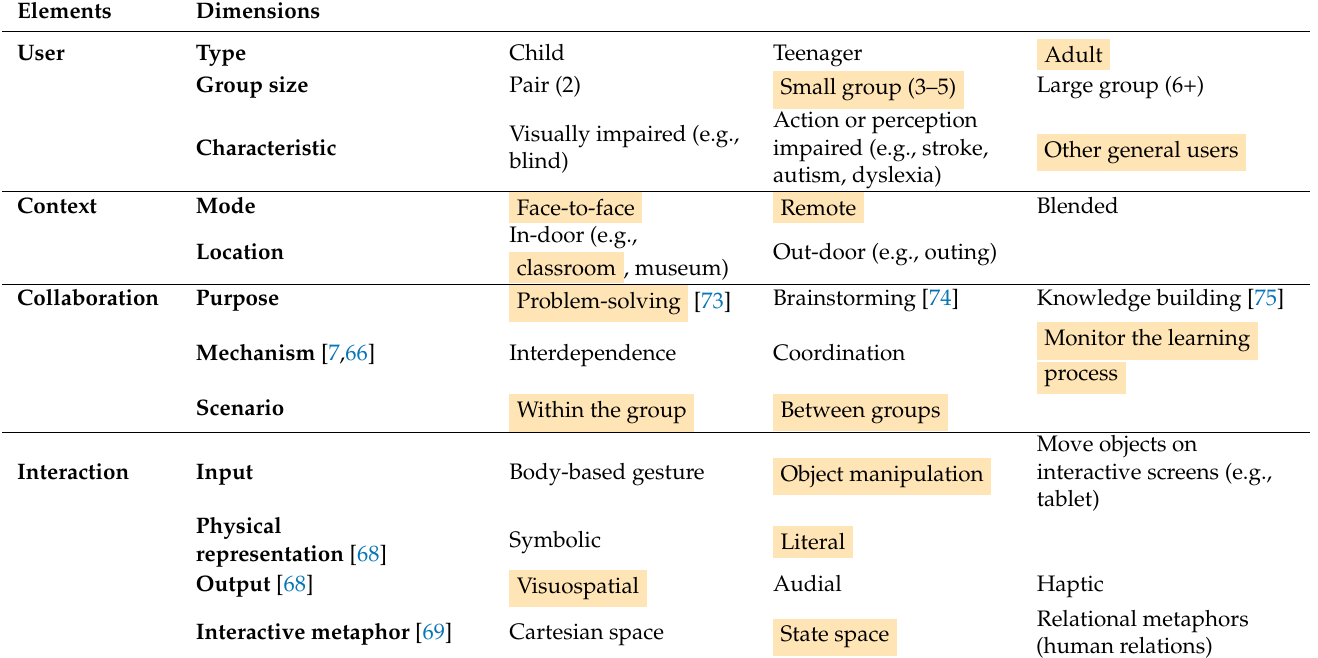
Table 4. Design dimensions we used in this paper are indicated with peach background color